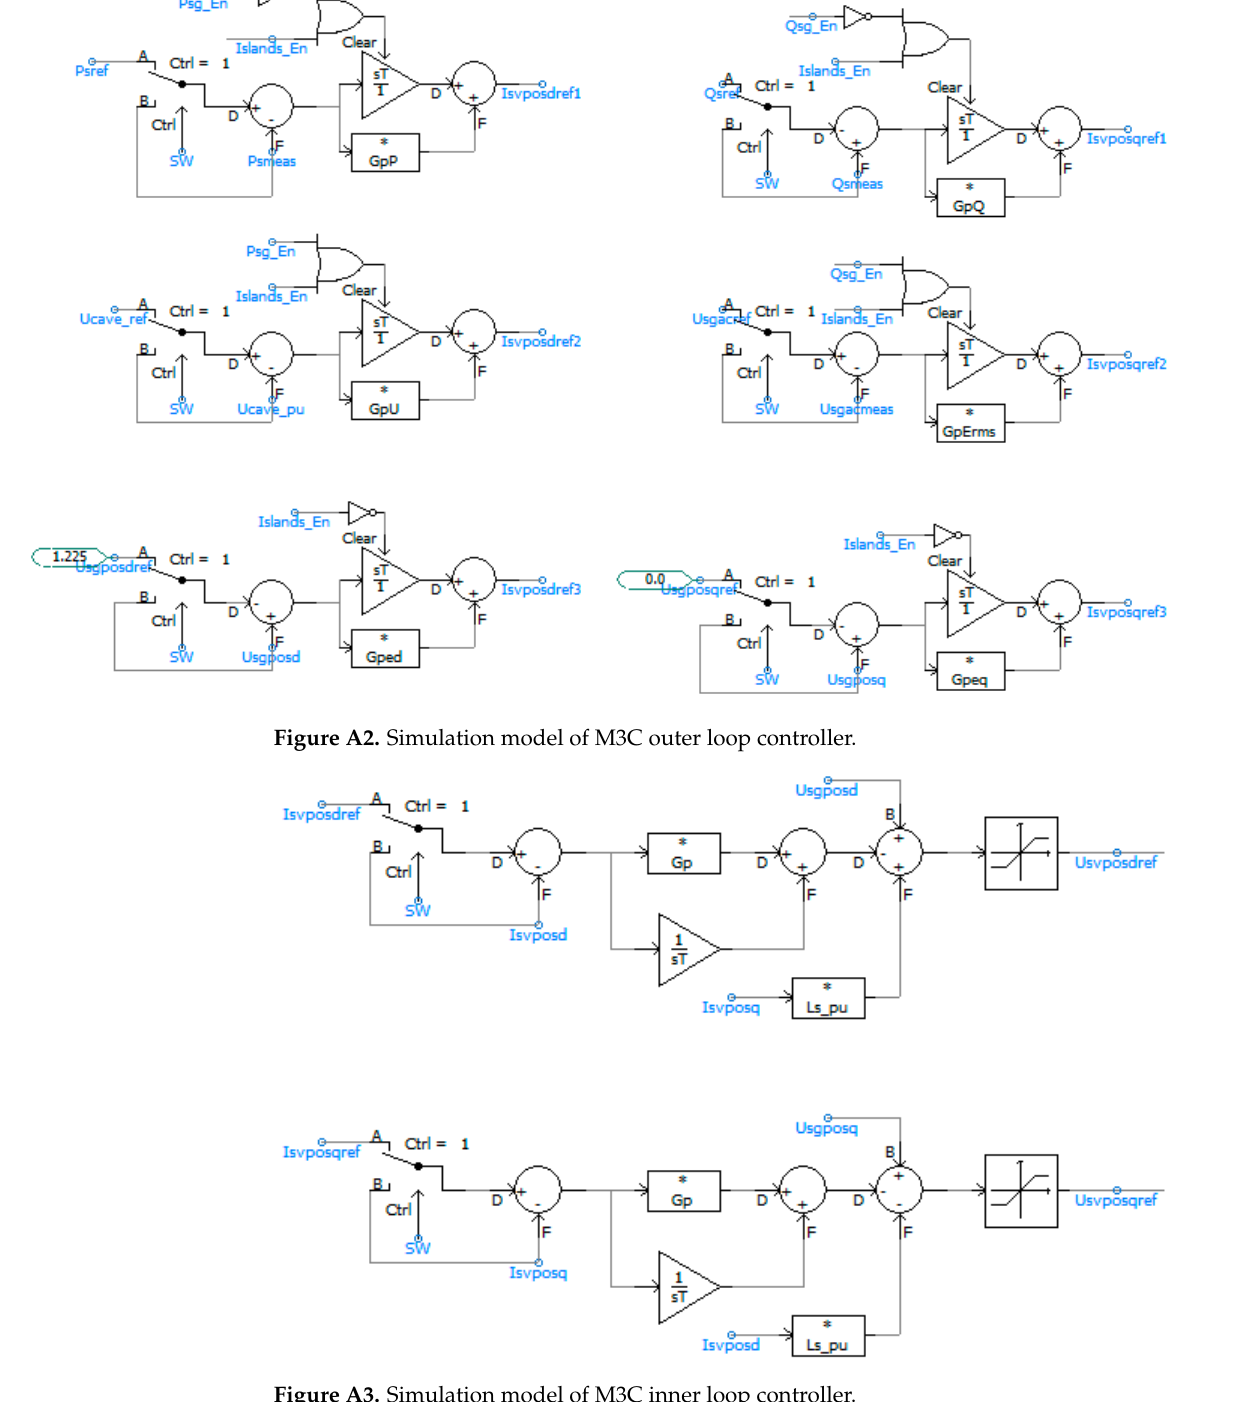
Figure A3. Simulation model of M3C inner loop controller.